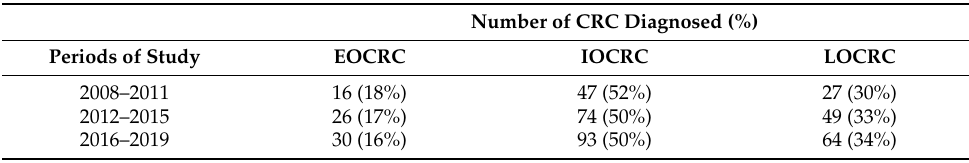
Table 2. Colorectal diagnosis trends according to age over the years.